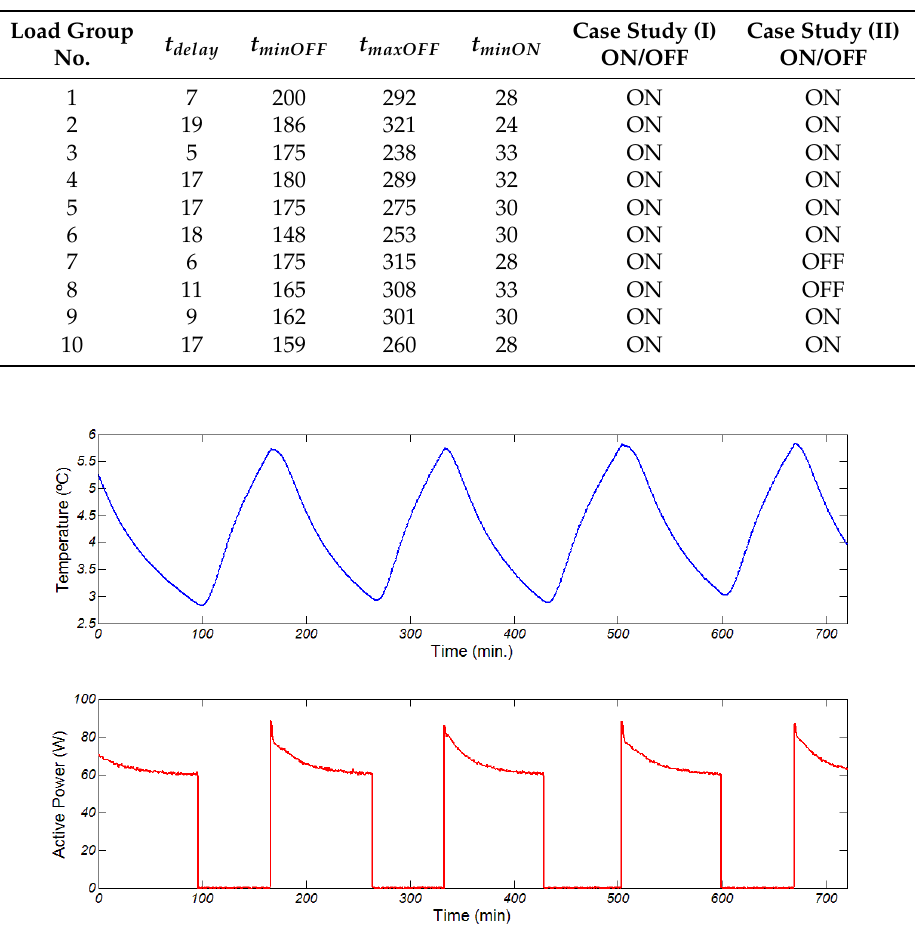
Figure 10. Fridge temperature and power demand profile under normal